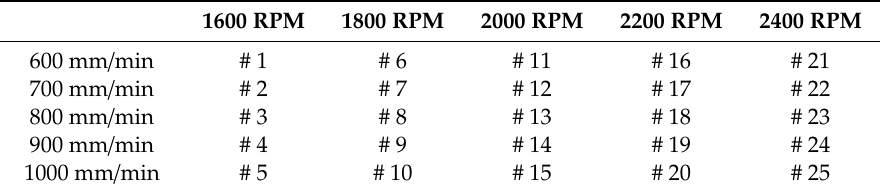
Table 4. Experimental conditions for